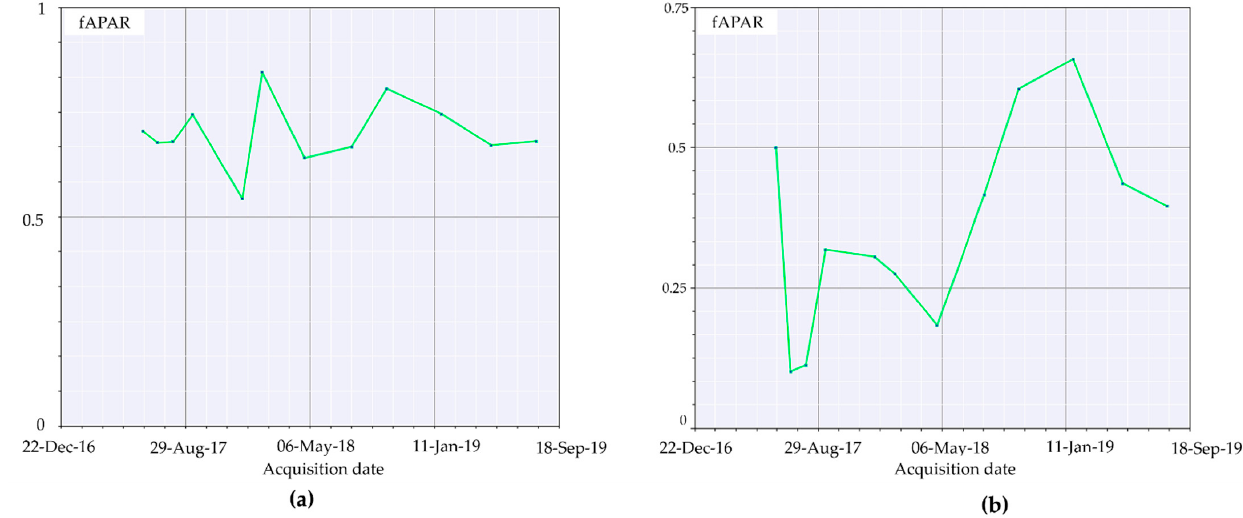
Figure 9. fAPAR representation from 4 June 2017 to 3 August 2019.